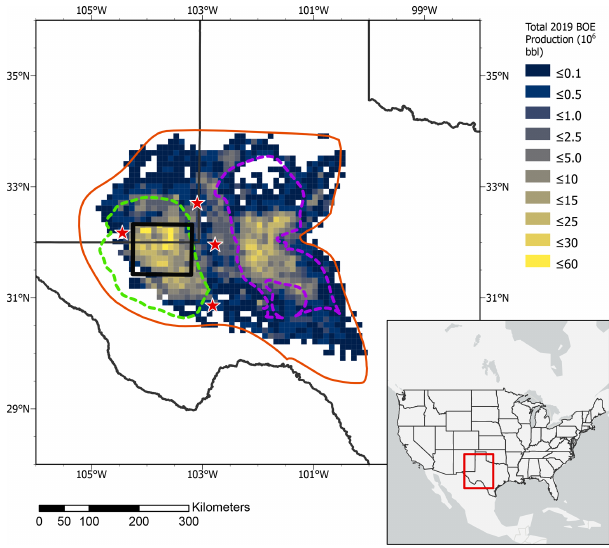
Figure 1. Regional map with outlines of the Permian Basin (or- ange), Delaware and Midland subbasins (dashed green and pur- ple), and the 100km × 100km study area (black). Locations of the methane measurement tower sites are shown with red stars. A heatmap displays combined natural gas and oil production from 2019 expressed in barrel-of-oil equivalent (BOE) and gridded to 0.1 ◦ × 0.1 ◦ resolution (Enverus, 2021). Map was generated in Ar- cGIS Pro with imagery provided by Esri, Garmin, FAO, NOAA, and